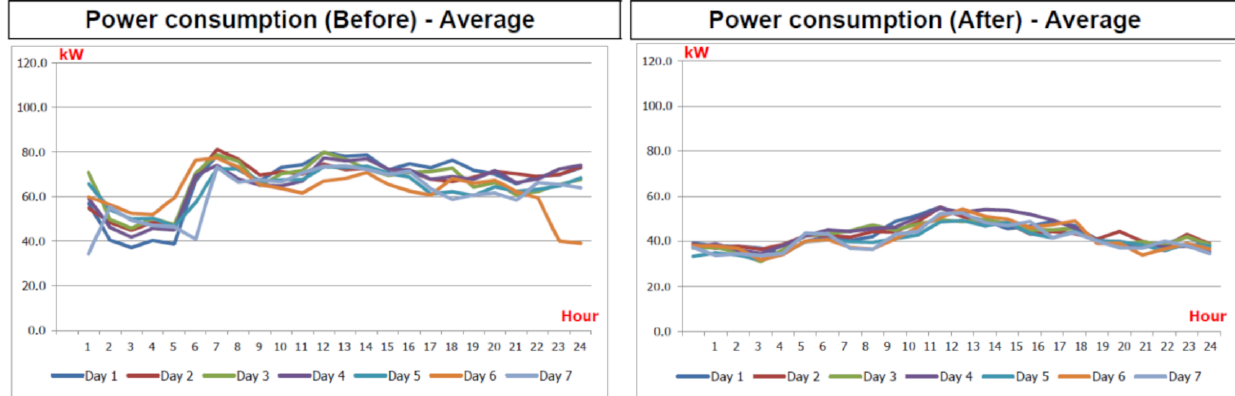
Figure 9. Average power consumption per hour before and after retrofits for store No.2